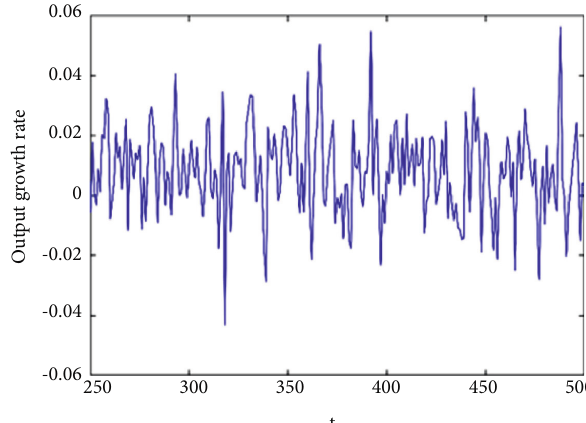
Figure 7: Time series evolution of output growth